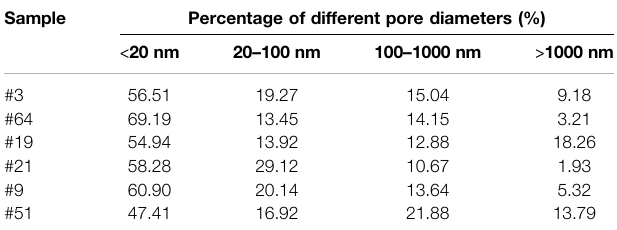
TABLE 4 | Statisticson the percentage ofdifferent pore diameter distribution after cracking. Sample